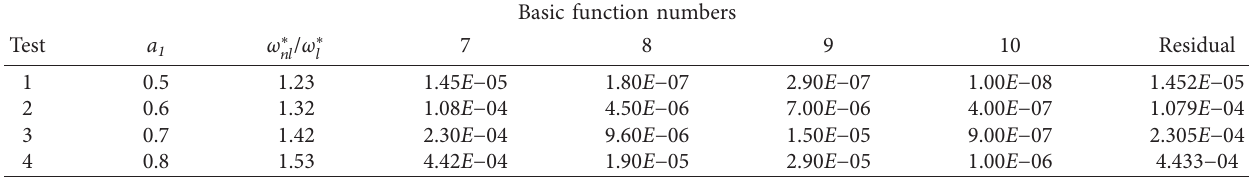
Table 2: The frequency differences and residual for each value of a